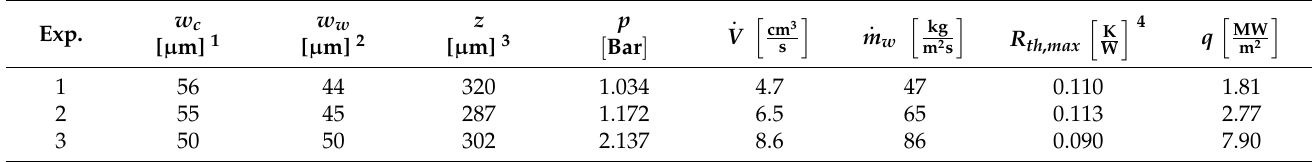
Table 5. Experimental VLSI heat sink with water filled microchannels